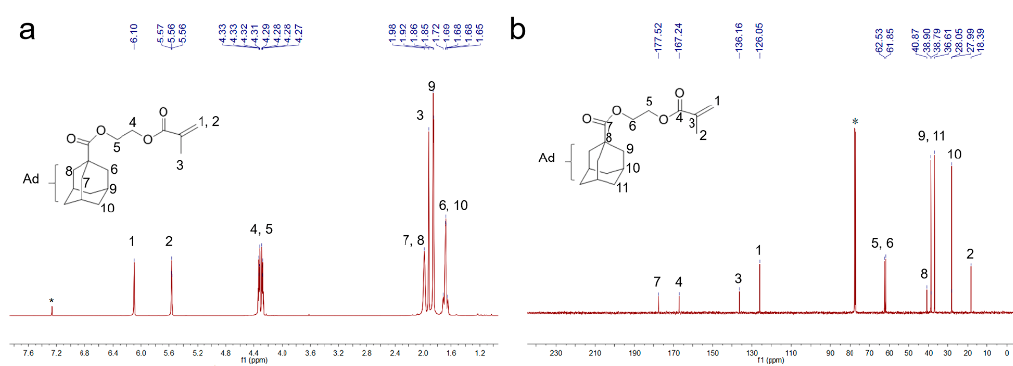
Figure 5. 2-Hydroxyethyl-methacrylate-adamantane (HEMA-Ad) spectra: ( a ) 1 H NMR spectrum; ( b ) 13 C NMR spectrum.